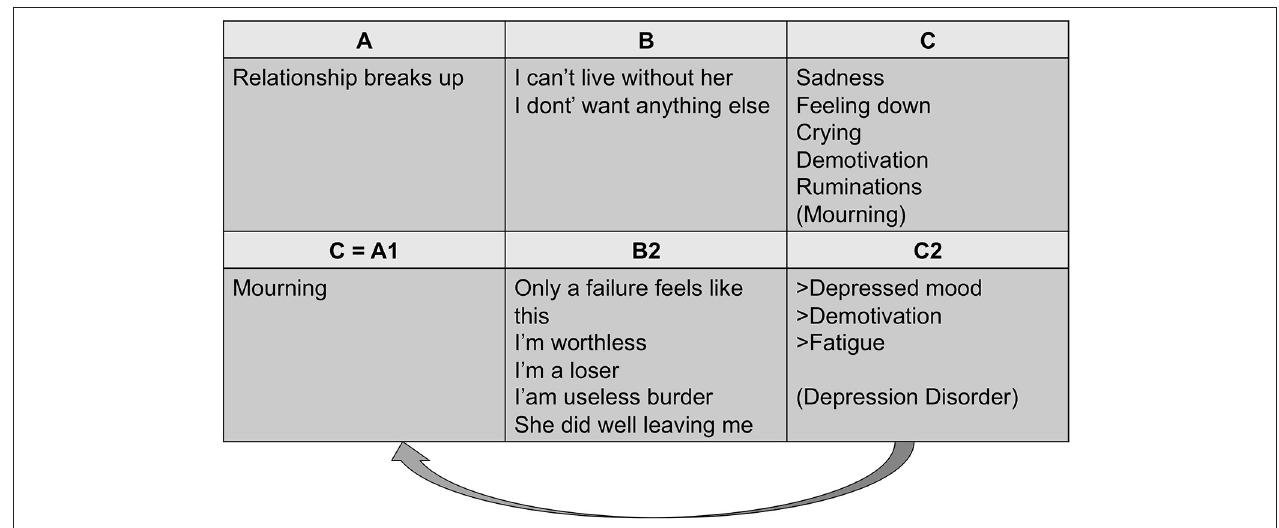
FIGURE 1 | Meta-emotional problem in depression